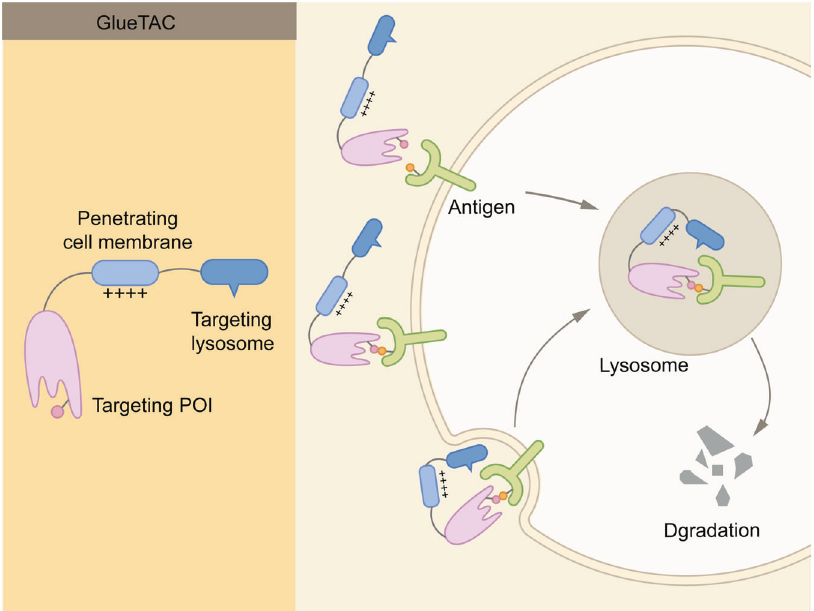
Fig. 9 Schematic representation of GlueTAC. GlueTAC consists of a covalently-modi fi ed nanobody, a Cell-penetrating peptide (CPP), and a lysosome-sorting sequence. The nanobody is responsible for targeting POI, and the CPP induces endocytosis of the GlueTAC-POI complex and subsequent lysosomal degradation